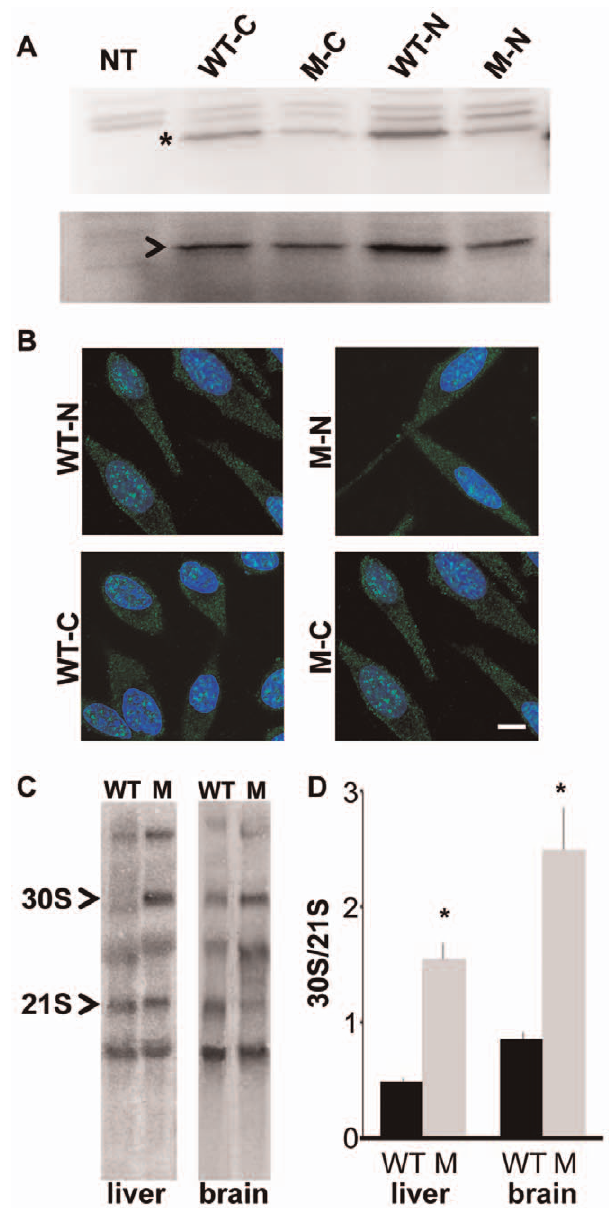
Figure 2. Rps7 Mtu shows reduced function in ribosomal precursor processing. (A) Western blot showing similar levels of expression for N- and C-terminal FLAG-tagged wild-type RPS7 (WT-N and WT-C, respectively) and RPS7 Mtu (M-N and M-C, respectively) proteins in HEK-293 cells. The RPS7-specific band is indicated by *, and NPT2 (arrowhead) expression is shown as a control. (B) Subcellular localization of N- and C-terminal FLAG-tagged RPS7 proteins. Wild-type RPS7 and RPS7 Mtu both localize to speckles in the nucleus and are observed throughout the cytoplasm. Scale bar=10 um. All panels are at the same magnification. (C) Representative Northern blot analysis of liver and brain RNA from wild-type (WT) and Rps7 Mtu / + (M) mice detecting various rRNA precursors using a probe within the internal transcribed spacer (ITS1). The 30S and 21S rRNA precursors are indicated. (D) Quantitation of the signals of Northern experiments reported as the ratio between 30S and 21S rRNA precursors was significantly different between Rps7 + / + and Rps7 Mtu / + (* indicates p , 0.01). The average of the values is reported in the bar graphs with